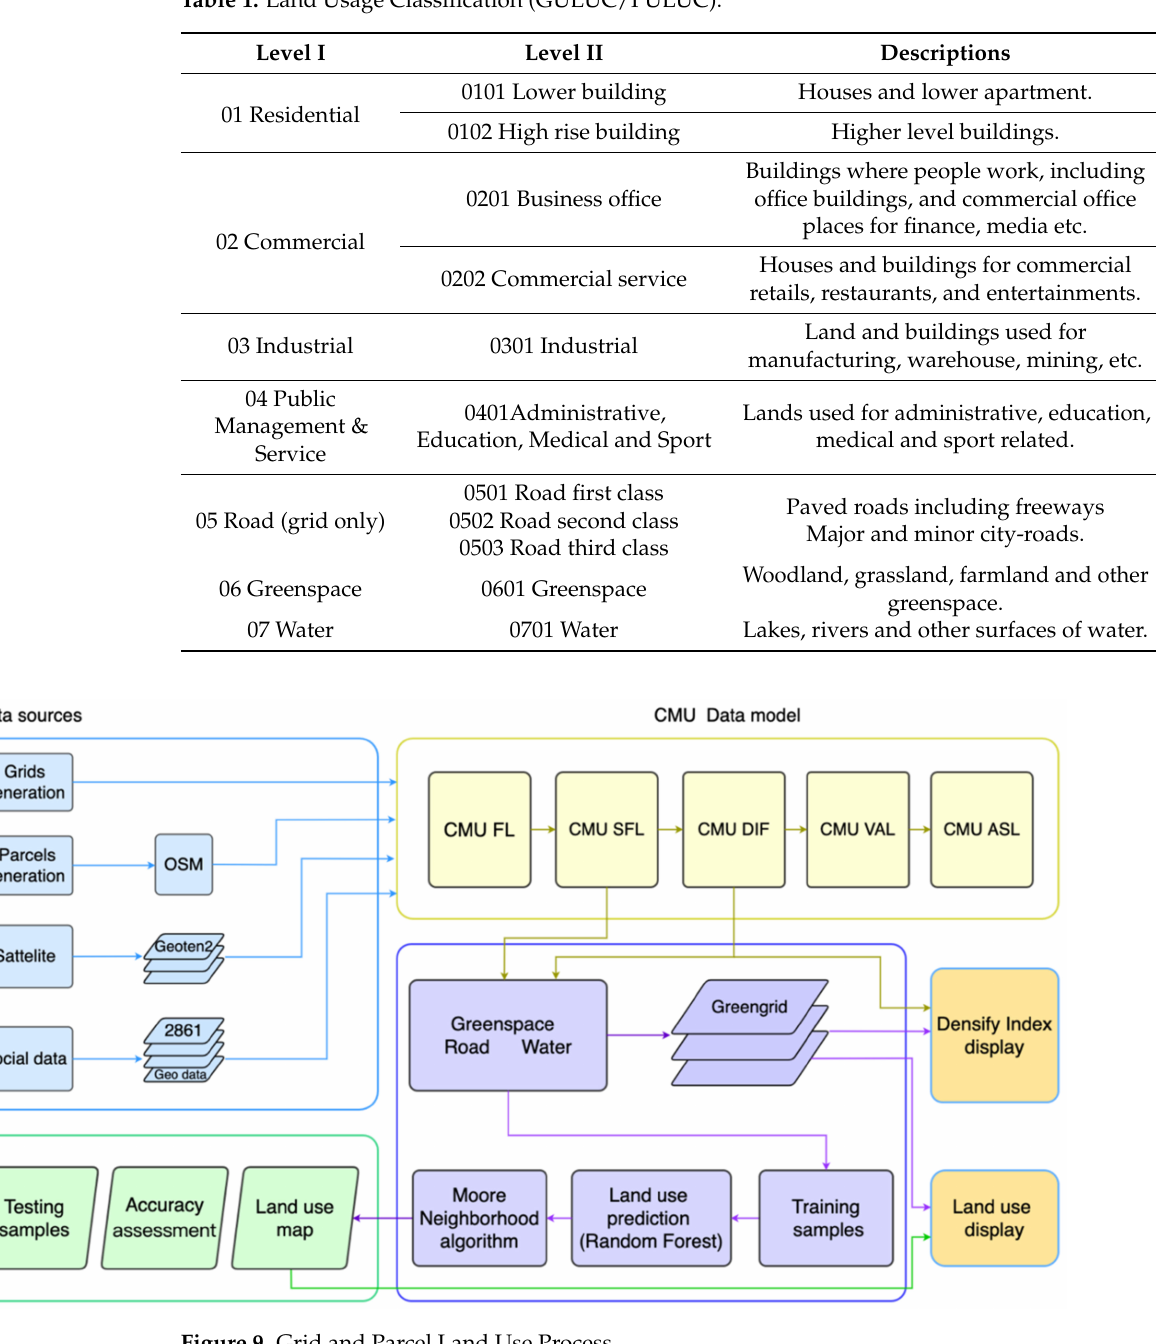
Figure 9. Grid and Parcel Land Use